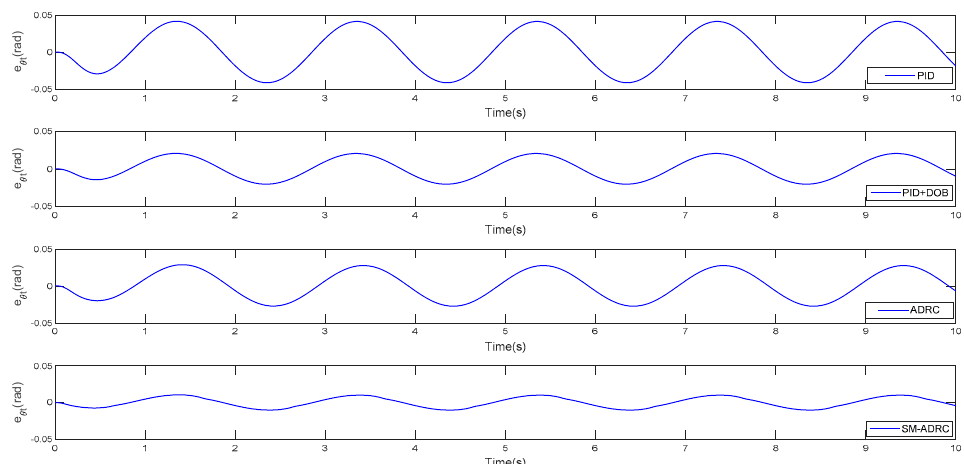
Figure 4. Simulation results with sinusoidal torque disturbance.